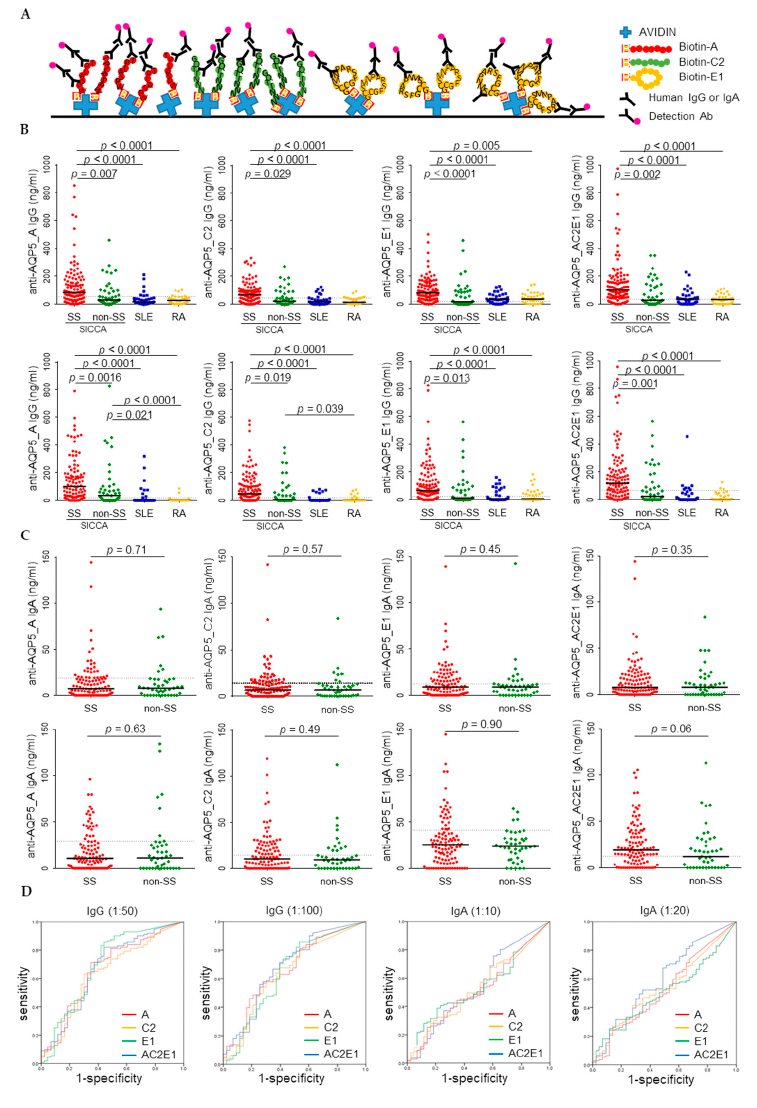
Figure 2. Higher levels of anti-AQP5 IgG were detected in SS than in non-SS, systemic lupus erythematosus (SLE), or rheumatoid arthritis (RA) by enzyme-linked immunosorbent assay (ELISA). ( A ) A diagram of the ELISA strategy used. ( B ) Concentrations of IgG reactive with A, C2, E1, or a mixture of A, C2, and E1 epitope peptides were measured by ELISA using sera diluted at 1:50 (top panel) or 1:100 (bottom panel). ( C ) Concentrations of IgA reactive with A, C2, E1, or a mixture of A, C2, and E1 epitope peptides were measured by ELISA using sera diluted at 1:10 (top panel) or 1:20 (bottom panel). ( D ) ROC curves of anti-AQP5 IgG and IgA. The dotted lines in graphs B–C present the cut-off values based on the ROC analysis.